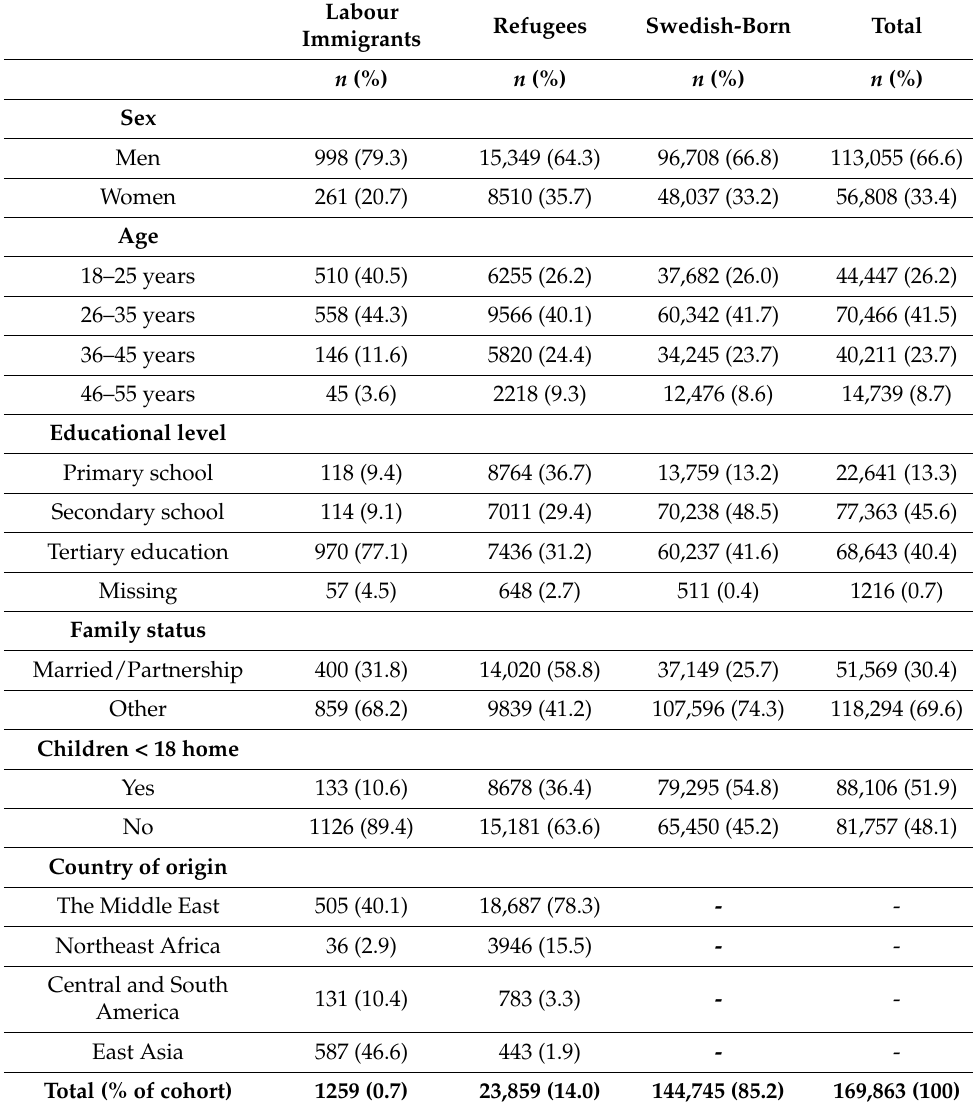
Table 1. Characteristics of the study population at year 1 after receiving a residence permit ( n = 169,863). Labour Refugees Immigrants